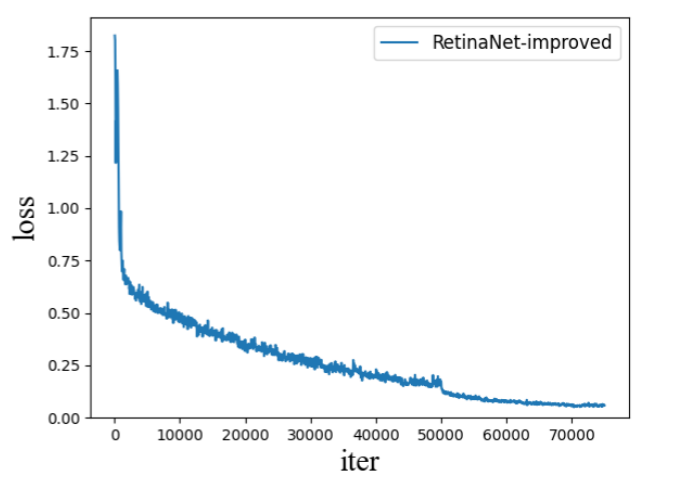
Figure 7. Loss curve of RetinaNet.